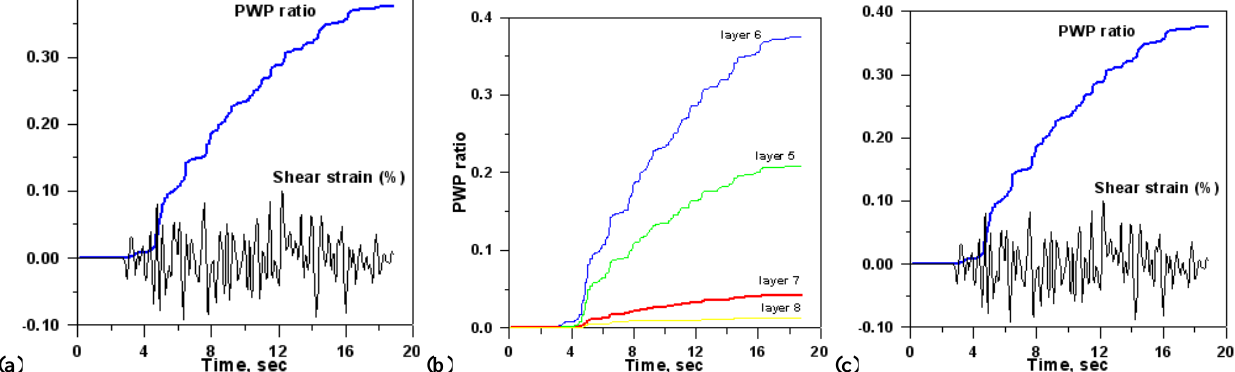
Fig. 28. Stress-strain history (a) for the layer with high probability to liquefy; PWP time histories at different ground level (b) ; PWP and shear strain time histories (c) for the layer with high probability to liquefy.